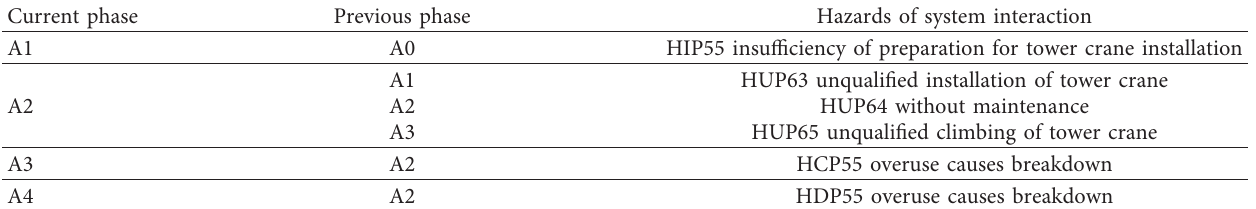
Table 10: Hazards of system interactions.